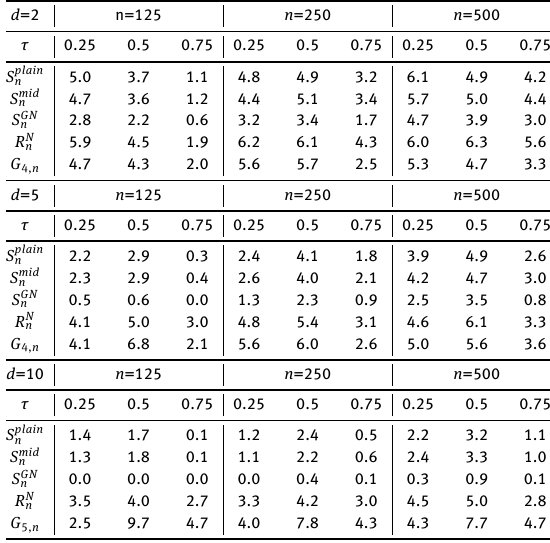
Table 2: Percentages of rejection at 5% significance level, as estimated from 1000 replicates, for the tests based on S plain n , S mid n , S GN n , R N n and G 4, n under the Pearson Type II copula. d =2